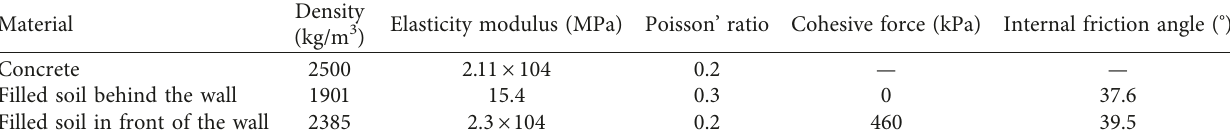
Table 2: Material parameters of the concrete and filled soil.